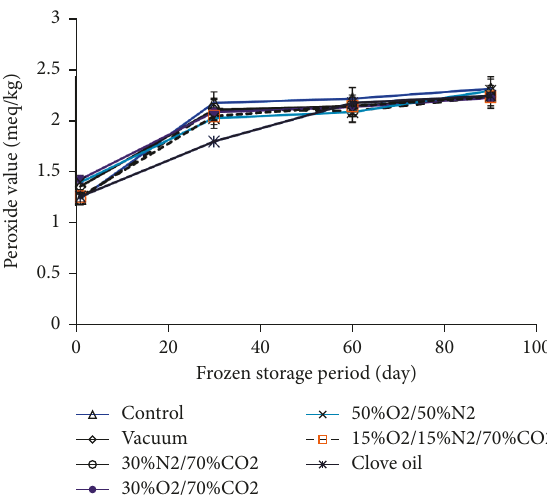
Figure 4: Peroxide value vs. MAP treatments and